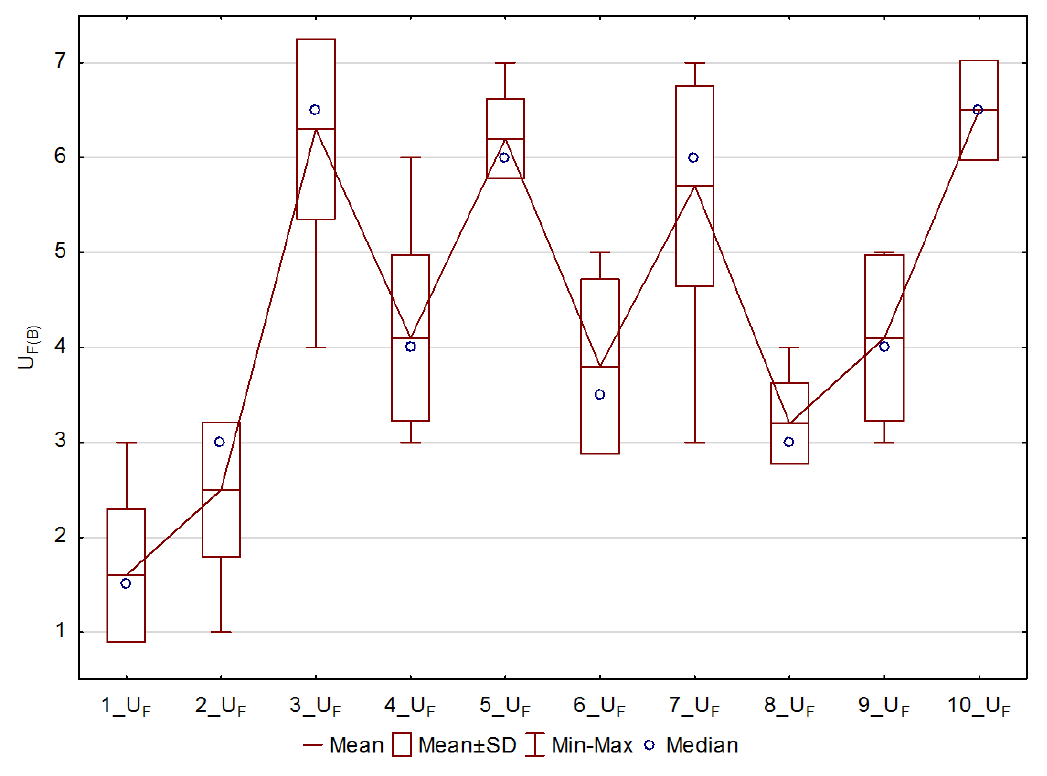
Figure 17. Floor uniformity perception for group B.